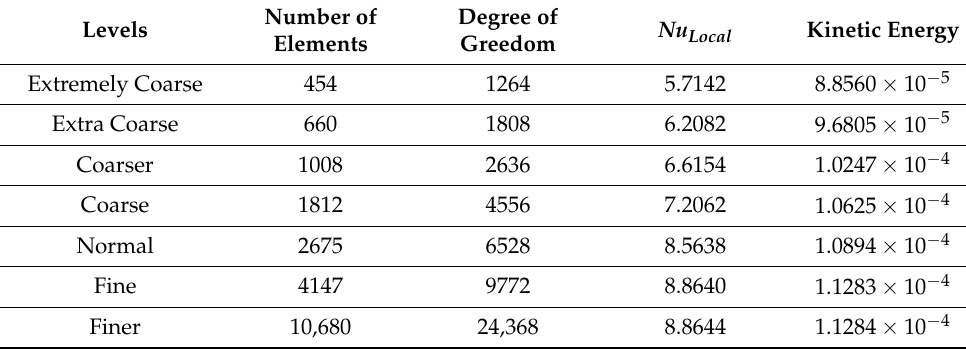
Table 1. Grid independence test at different refinement